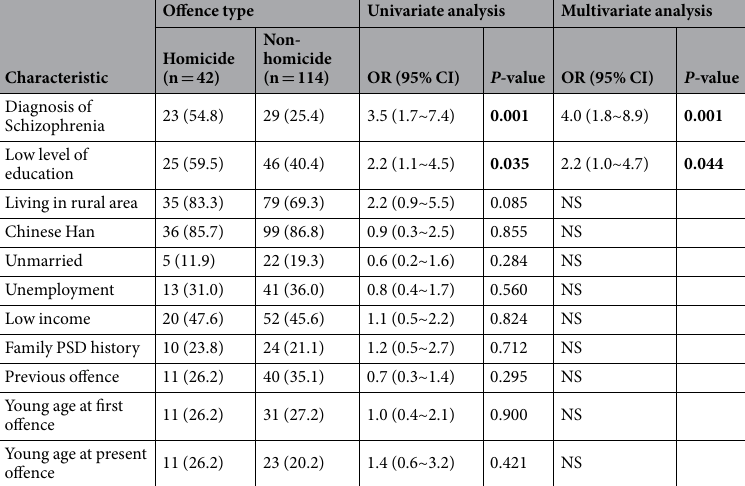
Table 3. Univariate and multivariate analyses for homicide (n, %). Bolded values: < 0.05; PSD: psychiatric disorders; PSM: propensity score matching; NS: not significant in the final